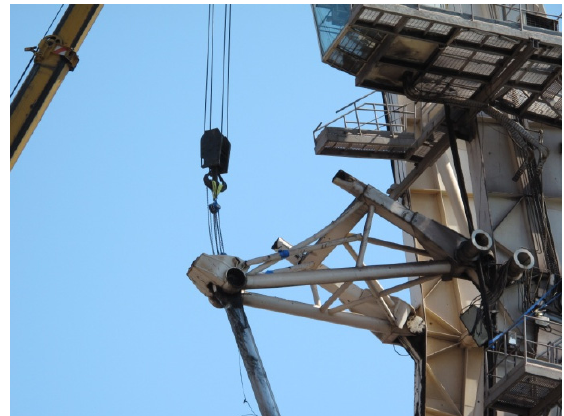
Figura 1: Zona di rottura del traliccio costituente il braccio della gru.